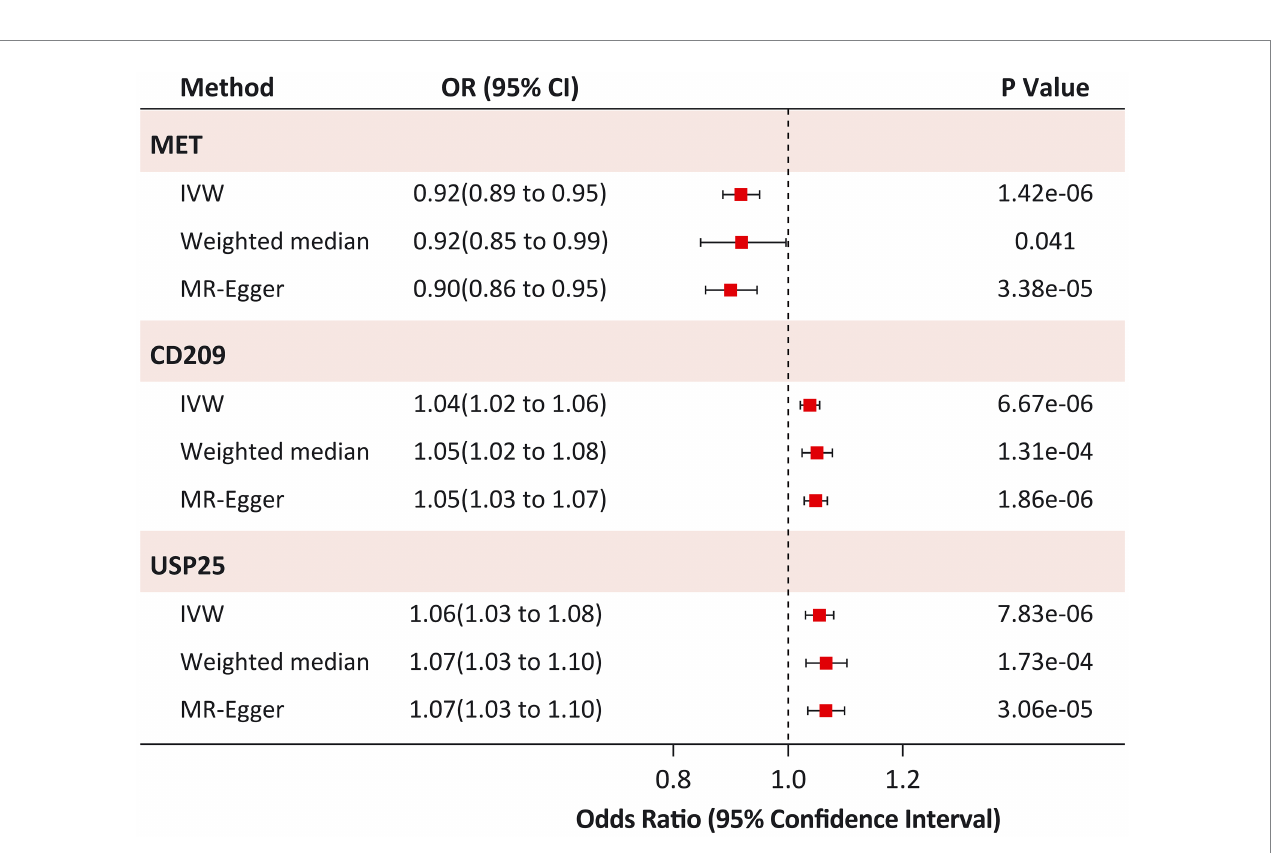
FIGURE 3 Sensitivity analysis of causal associations between identified proteins and Heart Failure. IVW, inverse